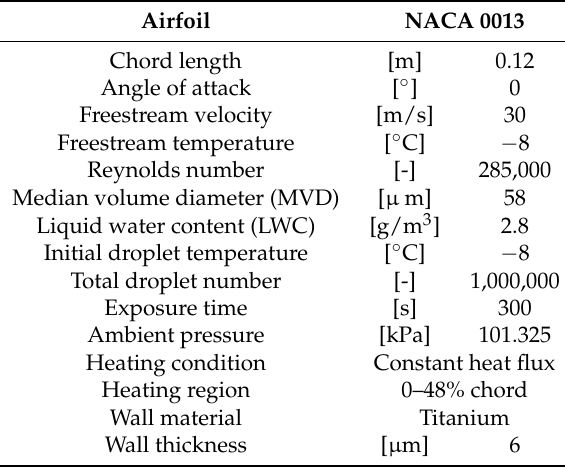
Table 1. Numerical conditions for heater validation